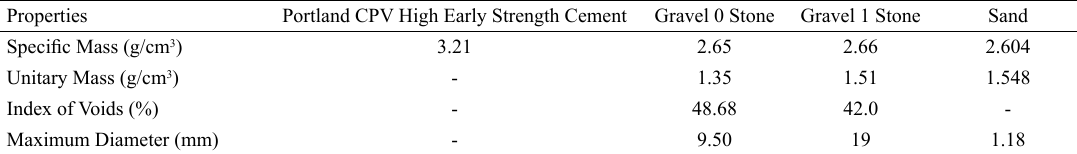
Table 1. Properties of materials used the production of concrete.